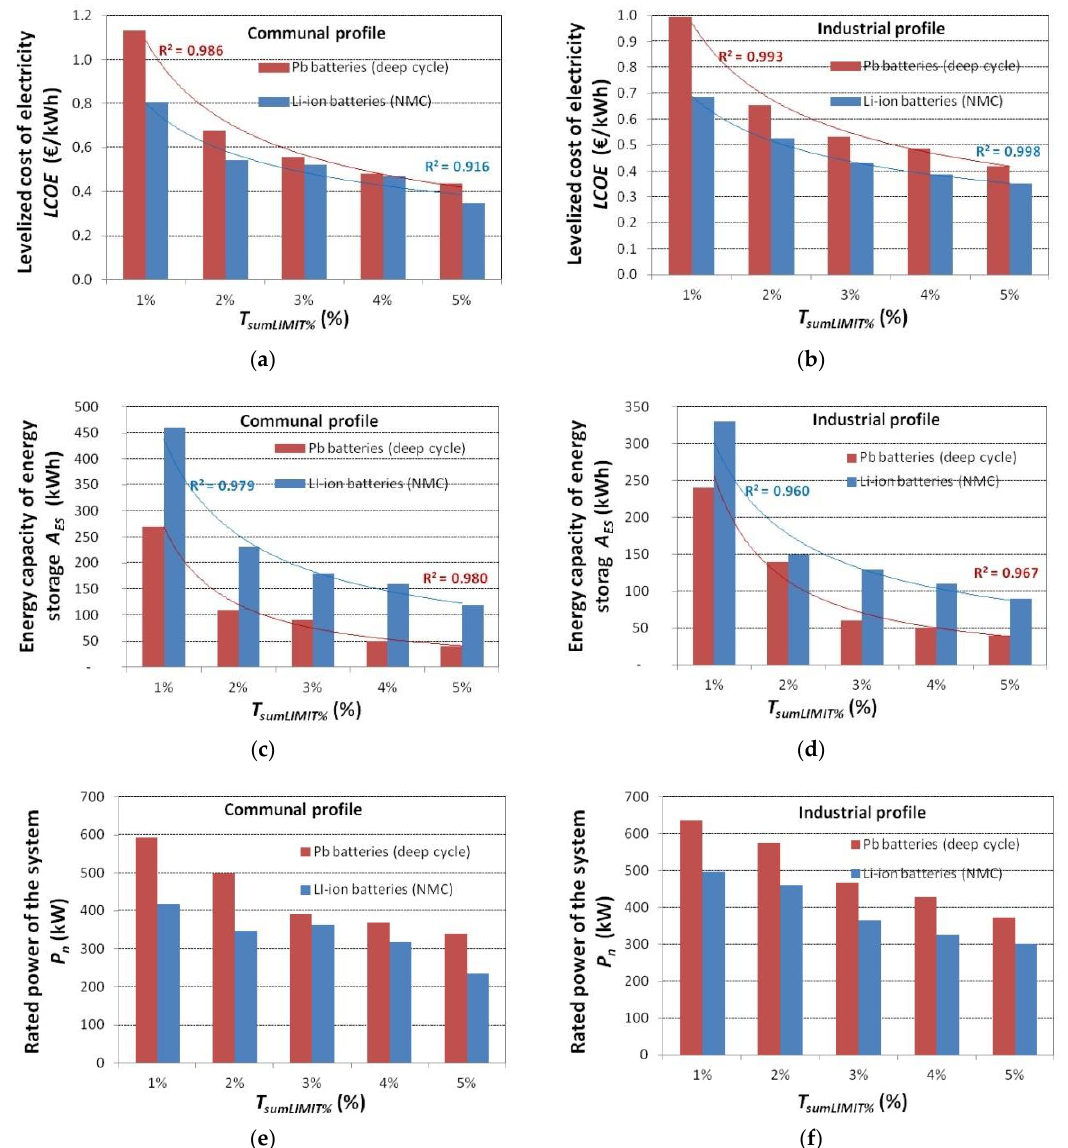
Figure 11. Changes in selected parameters of optimized systems with no limit for power P n in the function of time T sumLIMIT% : the unit cost of generating energy ( LCOE ) consumed for supplying a communal load ( a ) and industrial load ( b ); energy capacity of a battery pack for a communal load ( c ) and industrial load ( d ); rated power of the power generation system P n for a communal load ( e ) and industrial load ( f ).